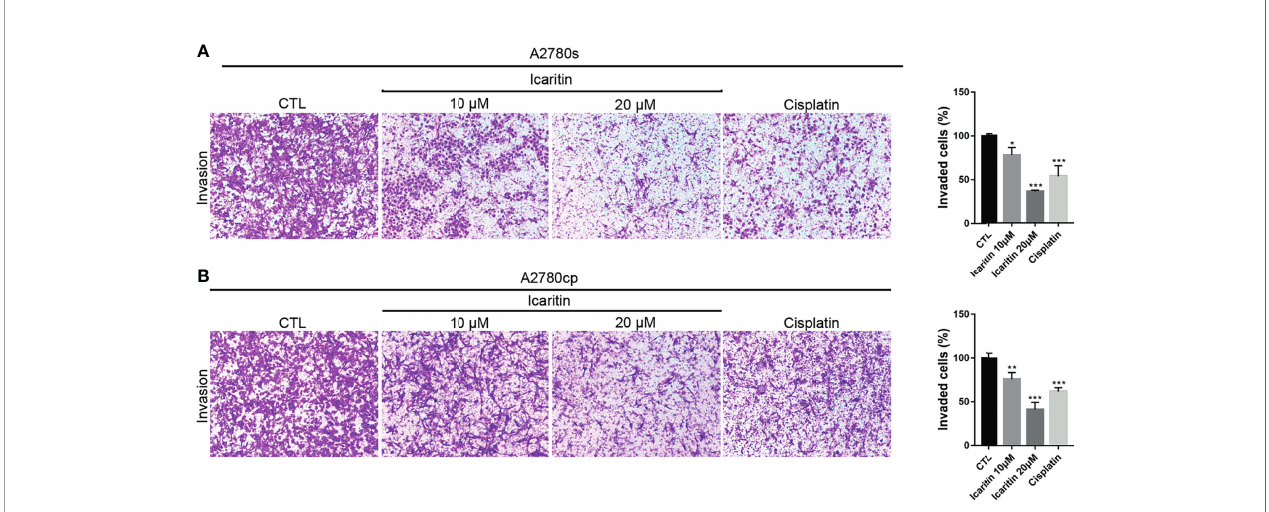
FIGURE 4 | Icaritin inhibits the invasion of ovarian cancer (OC) cells. (A) A2780s were treated with icaritin (20 m M) or cisplatin (1.6 m g/ml) for 24 h. Representative images and quanti fi cation of the invaded cells are shown. Data are represented as means ± SEM. *** p < 0.001 by 2-tailed Student ’ s t -test. (B) A2780cp cells were treated with icaritin (20 m M) or cisplatin (1.6 m g/ml) for 24 h. Representative images and quanti fi cation of the invaded cells are shown. Data are represented as means ± SEM. * p < 0.05, ** p < 0.01, *** p < 0.001 compared to CTL group by 1-way ANOVA followed by Tukey ’ s post-hoc